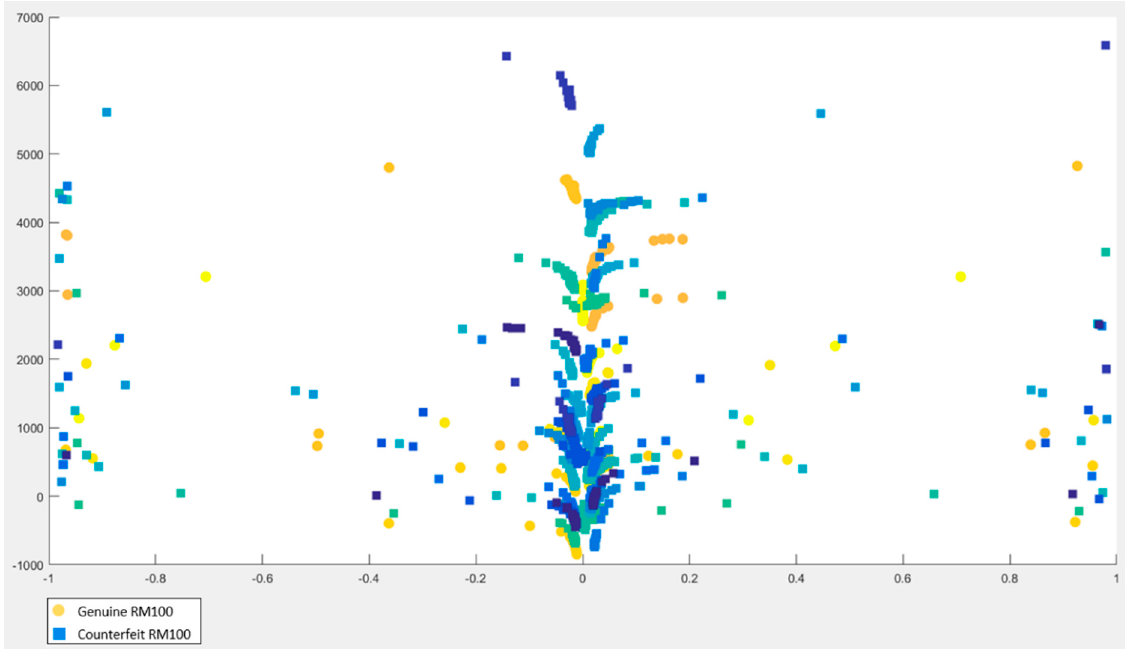
Figure 4. Coordinated FACS of genuine and counterfeit RM100.